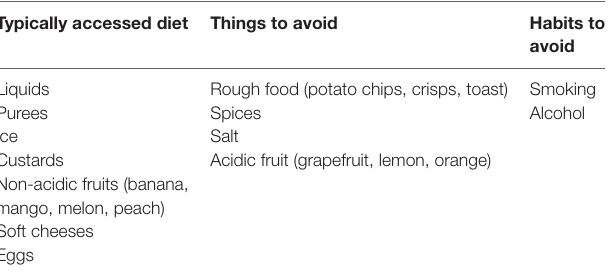
TAbLe 8 | Diet recommended for RiOM patients